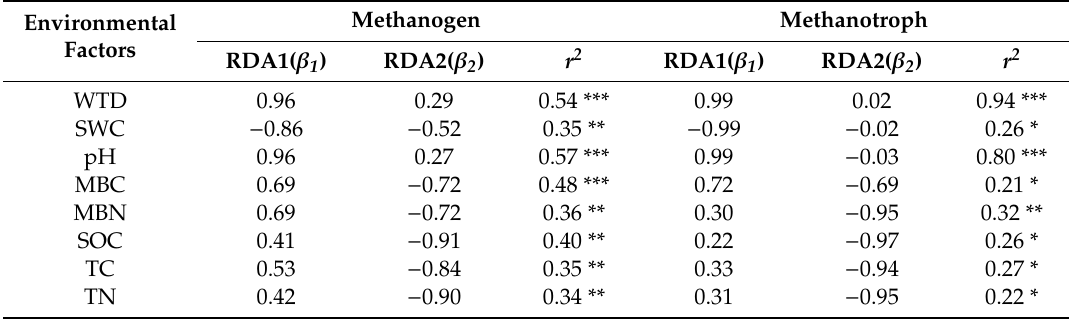
Table 2. The coefficients of correlation ( β ) and determination ( r 2 ) between methanogen and methanotroph communities and environmental factors by redundancy analysis (Koh, #46).